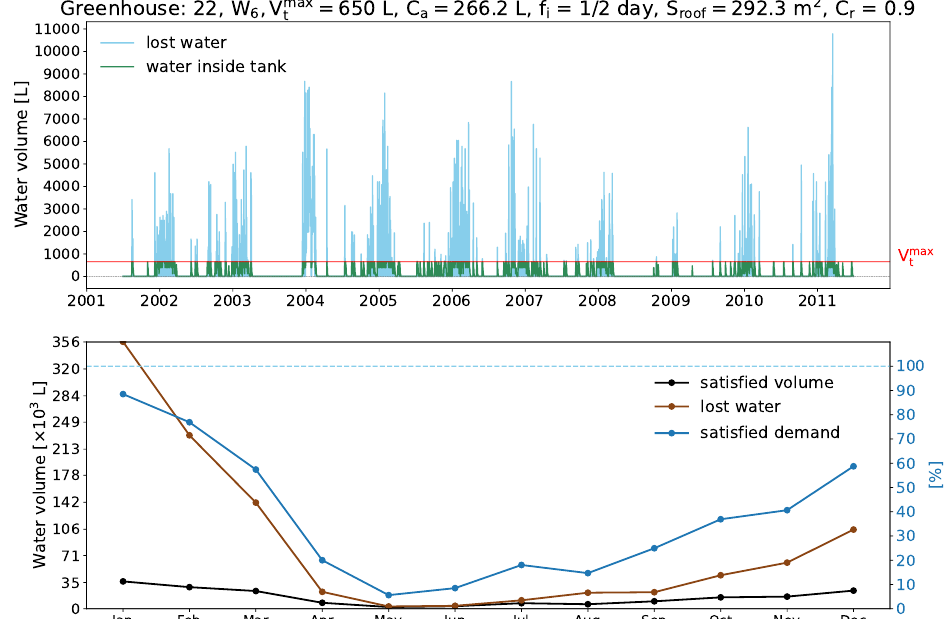
Figure 5. Example of a Type 1 simulation performed with Equation (2) for greenhouse 22 (see main characteristics in Table 1). The simulation is performed for the next set of parameters: S roof = 292.3 m 2 , C r = 0.9, W i = W 6 (second window of Copancara station, Table 1), f i = 1/2day, = 650 L. ( top panel ) Daily simulation of water inside tank (green) and lost water C a = 266.2 L, V max t (sky blue). Note that the amount of water inside the tank is V max as maximum. ( bottom panel ) The t 10-year monthly mean computed from daily data. The percentage of satisfied demand (sky blue) has been calculated taking into account the volume of water provided by the tank (black) with respect to the total required, while the water loss (brown) indicates the amount of water does not captured, most likely due to limitations in the storage capacity of the tank. Units of left y -axis are 10 3 L. For comparison, we show an example of Type 2 simulations for the same greenhouse in Figure 6. It has been performed for the following set of parameters: C r = 0.9, W i = W 6 , = 650 L. As seen, in this case, the mean k c = 0.9, S g = 250 m 2 , S roof = 292.3 m 2 , and V max t annual cycle has the same shape than Type 1 simulations, but the percentage of satisfied water demand is about 20% smaller during the wet season (November to April) and about 10% smaller during the rest of the year. The reason is that in this case, we are